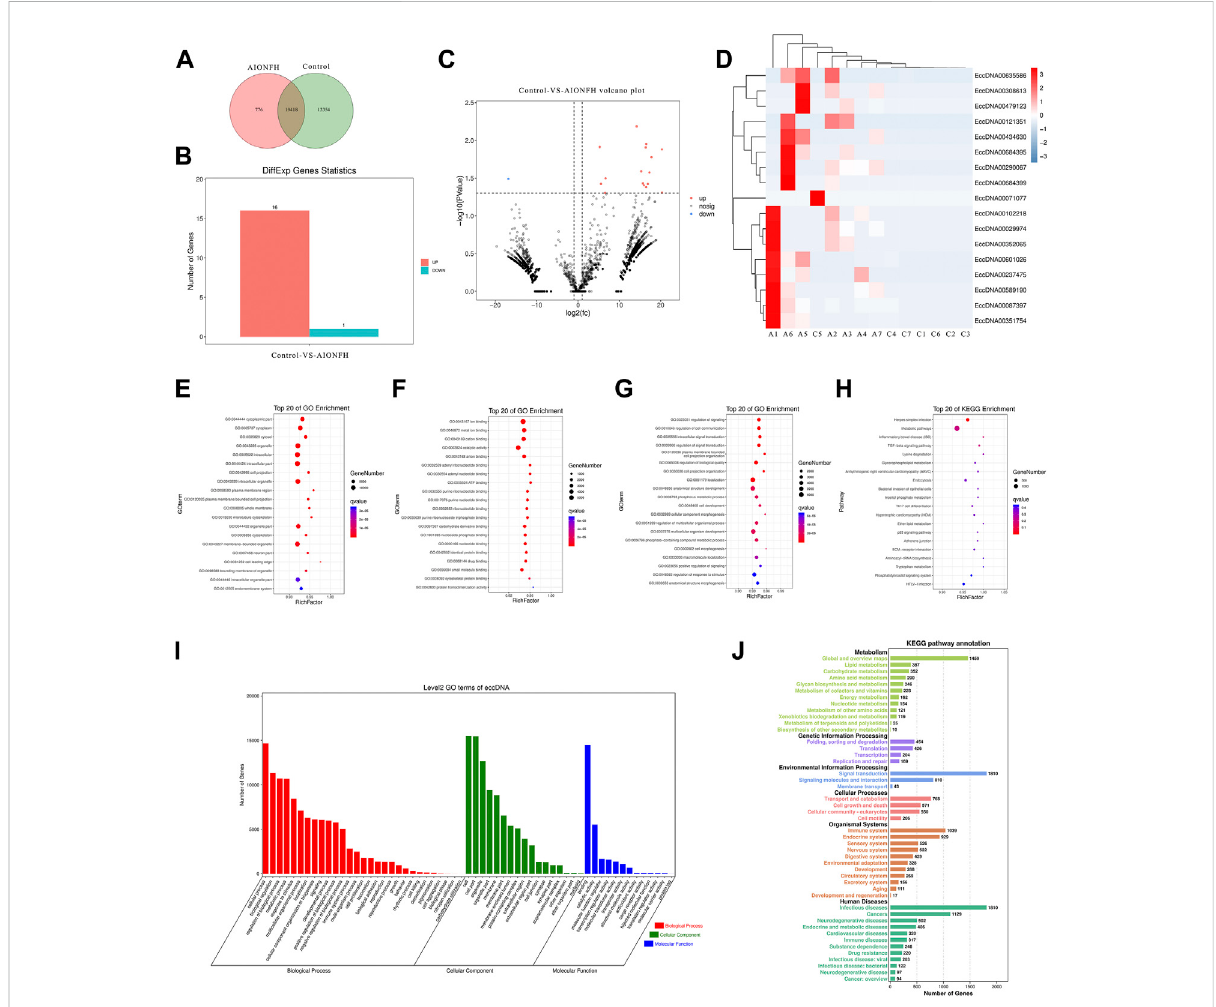
FIGURE 5 Bioinformatic analysis of functional attributes connected to eccDNAs changes in gene sets and signaling pathways. (A) . Common and speci fi c characteristics of eccDNAs of AIONFH group and control group were showed in Venn diagram. (B) . Upregulated and downregulated eccDNAs related genes. (C,D) . Volcano plot and hot map show the different genes. (E,F) . Top 20 of Gene ontology terms (Biological Processed, Molecular Functions, Cellular Components) enriched in the plot fi gure. (I) . GO biological process classi fi cation of genes. (H) . Top 20 of KEGG enrichment signal pathways. (J) . KEGG function enrichment